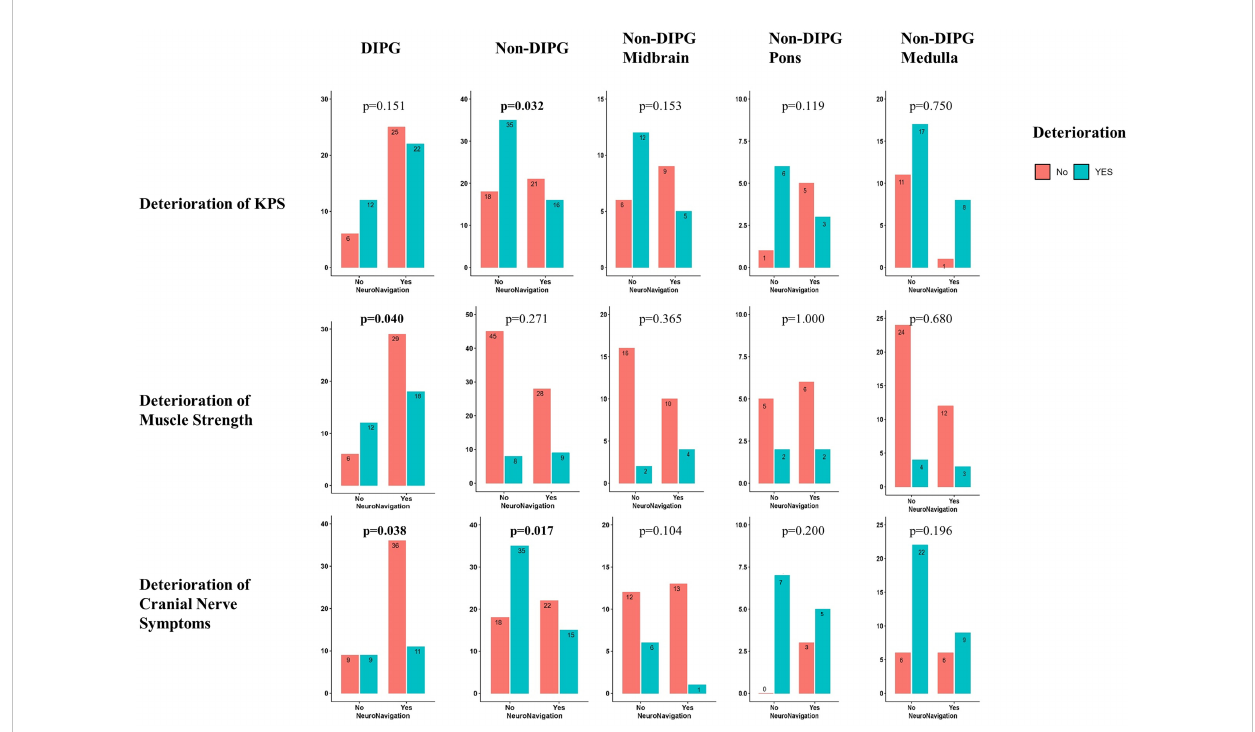
FIGURE 2 Strati fi ed illustration of differences in deterioration of quality of life between NN group and non-NN